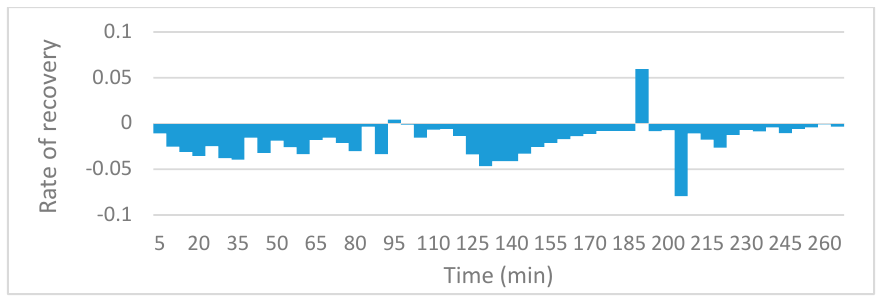
Figure 13. The slope function method to reveal the trend in local resistivity during the 1.0 wt% SiO 2 run no.1.